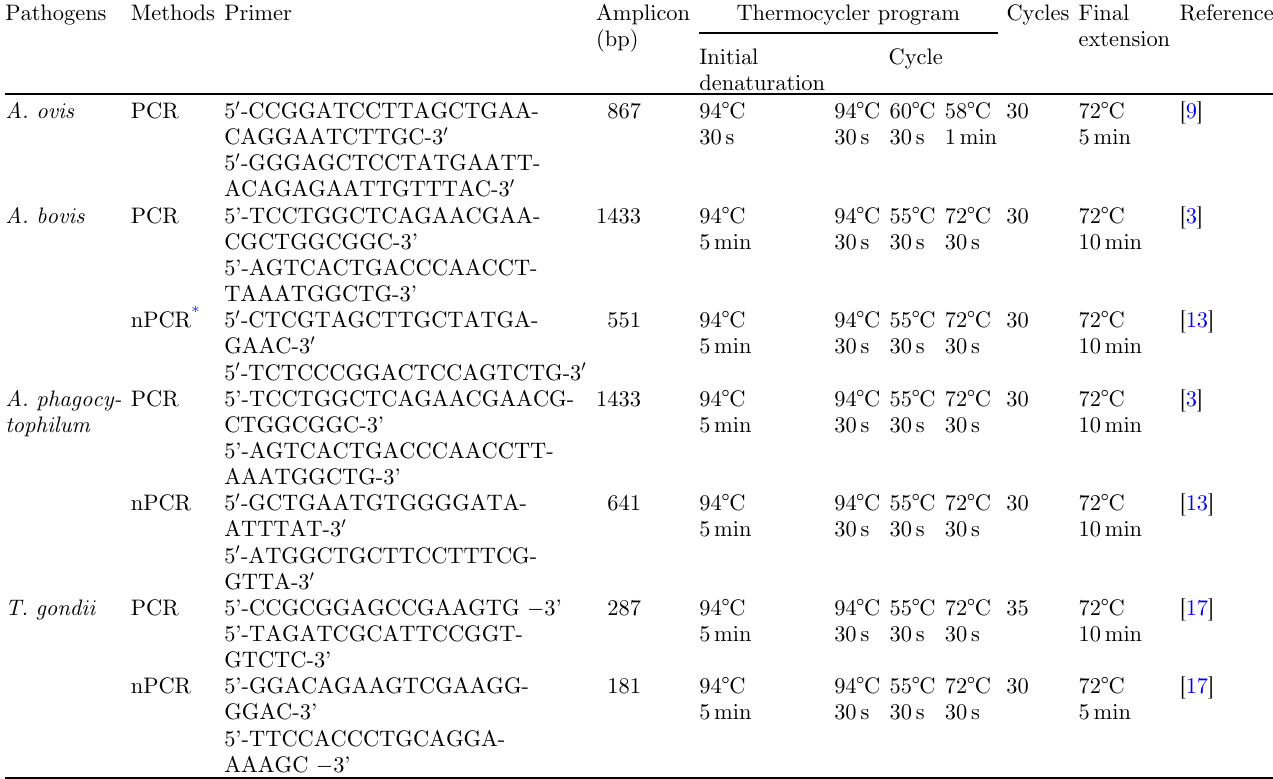
Table 1. Primers for T. gondii and Anaplasma detection in goats and PCR ampli fi cation conditions. Pathogens Methods Primer